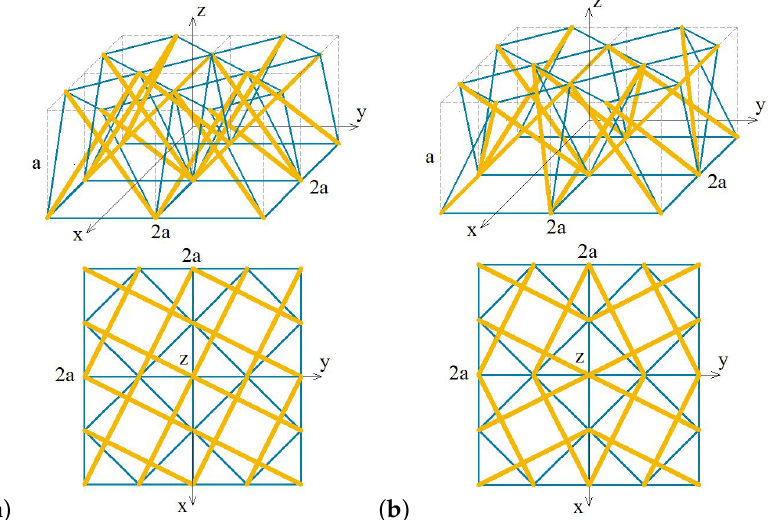
Figure 1. Two configurations of a 4-unit supercell: ( a ) A—anisotropic configuration. ( b ) B—orthotropic configuration. Struts are marked with thick yellow lines and cables with thin blue